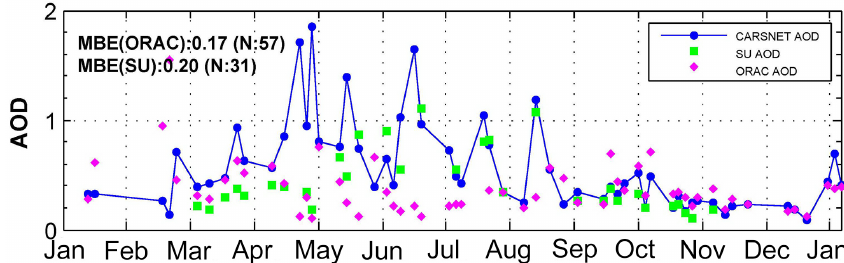
Figure 13. Time series comparison of AATSR AOD with CARSNET AOD over the site of Tazhong in